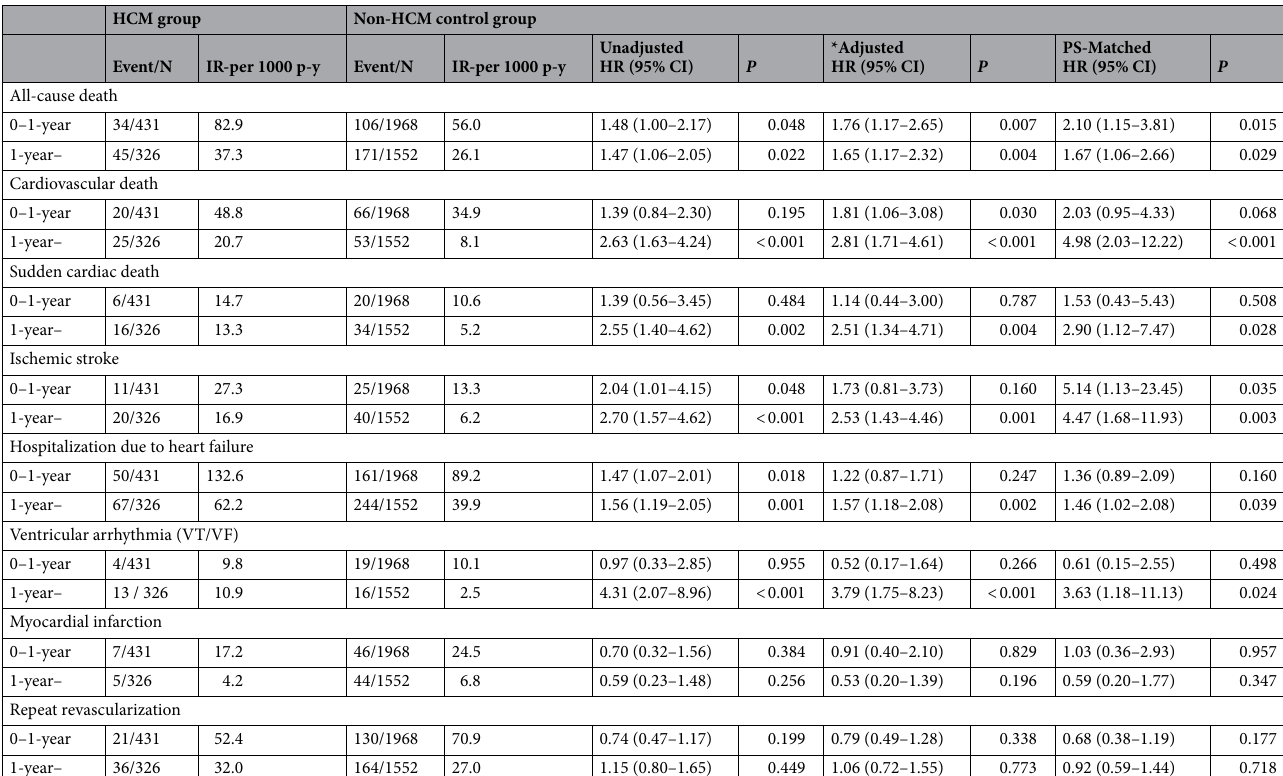
Table 3. Incidence and relative risk of clinical outcomes by 1-year landmark analysis. *Multivariable Cox regression model included age, sex, low income, revascularization due to acute MI, revascularization after